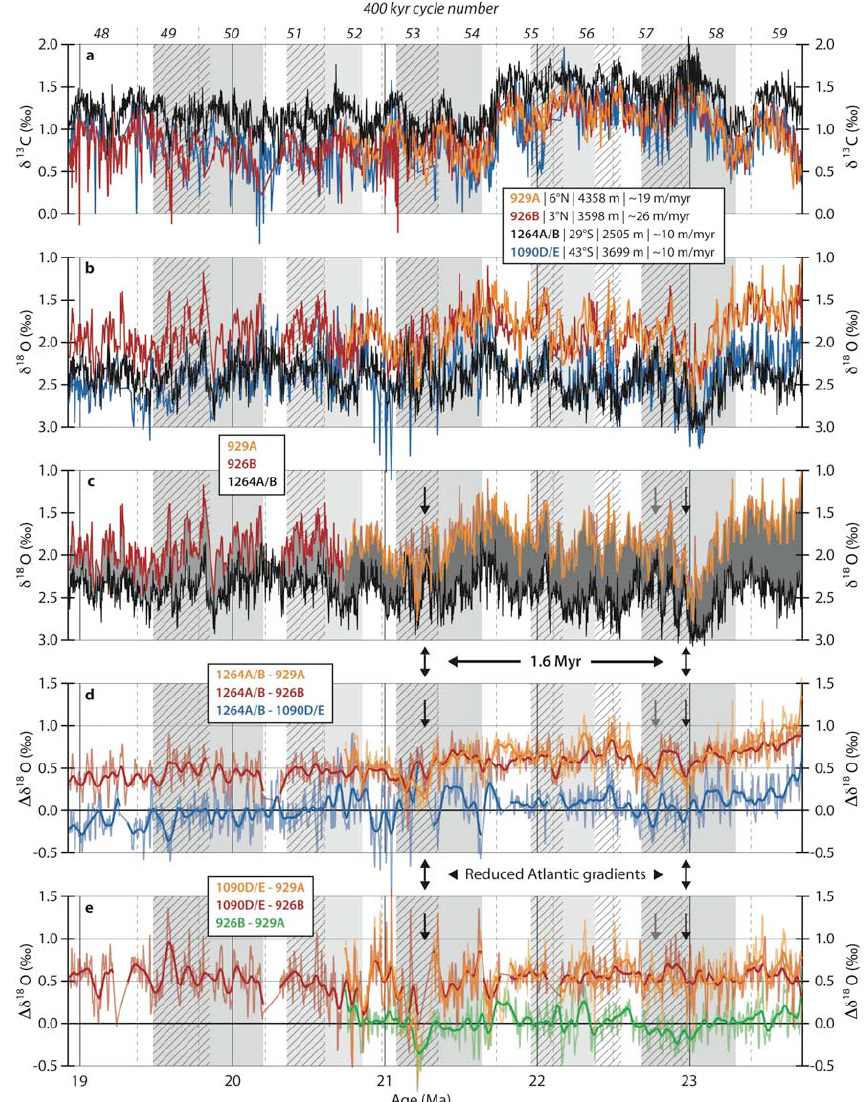
Fig. 4. Comparison of early Miocene stable isotope records. For more information see figure caption of Fig. 3. (a) The δ 13 C records. (b) The δ 18 O (+0.64‰) records. (c) As in panel (b). but without Site 1090. Gray areas in between the isotope records indicate the changes in Atlantic (intermediate) deep-water δ 18 O gradients. (d) 1δ 18 O of Sites 1264 − 929, 1264 − 926, and 1264 − 1090, to indicate the changes in Atlantic (intermediate) deep-water δ 18 O gradients. Shaded lines represent the 1δ 18 O of the 2kyr resampled data sets. Resampling was done using a Gaussian-weighted moving average (15kyr). Thick lines are the corresponding 100kyr Gaussian-weighted moving averages. Arrows indicate the occurrences of reduced gradients between equatorial and southern Atlantic. These two events occur 4 × 400kyr apart. (e) As in panel (d) but now for 1090 − 929, 1090 − 926 and 926 −